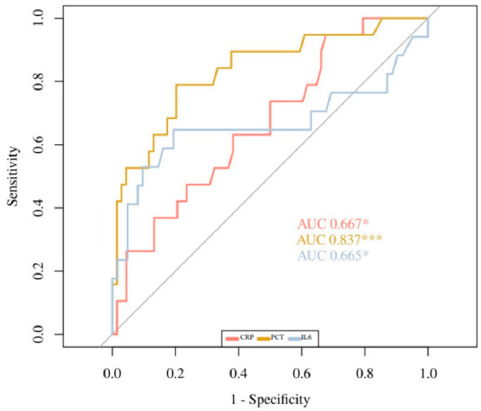
Figure 2. ROC Curves of CRP-2, PCT-2, and IL6-2. * p < 0.05, *** p < 0.001.